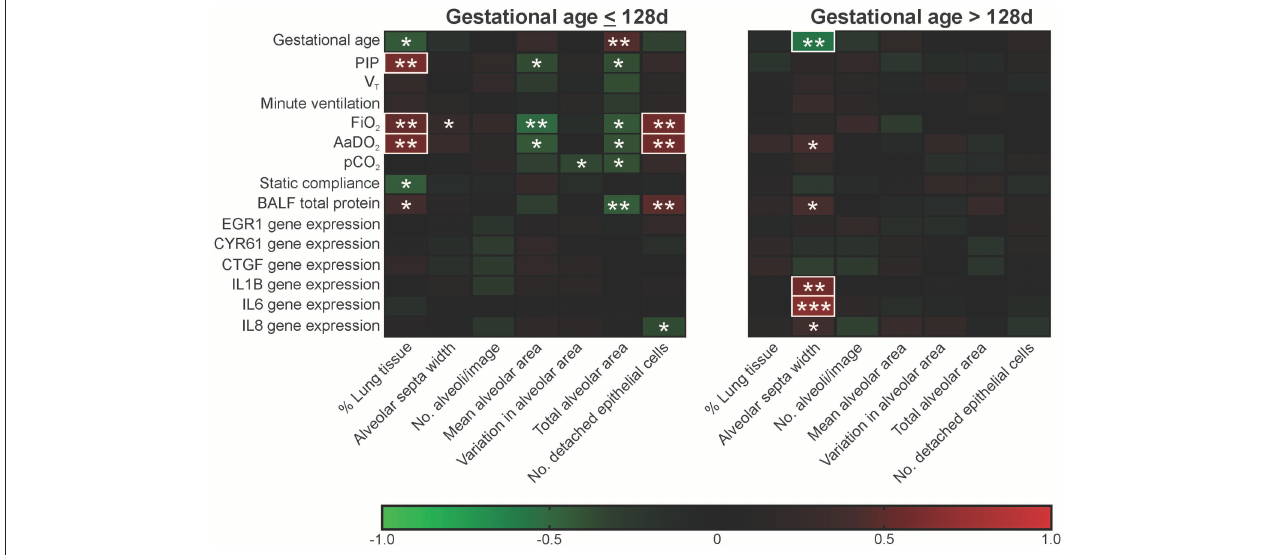
FIGURE 4 | Association between histological assessments and functional measures in ventilated lambs of gestational age ≤ 128 d and > 128 d. Red squares represent positive associations and green squares negative associations with color intensity indicative of strength of association (as shown in the color scale). R values of < -0.5 or > 0.5 are highlighted with a white box. Parametric data sets were analyzed using Pearson correlation coefficient and non-parametric data sets analyzed using Spearman’s correlation coefficient; * P < 0.05, ** P < 0.01, *** P <